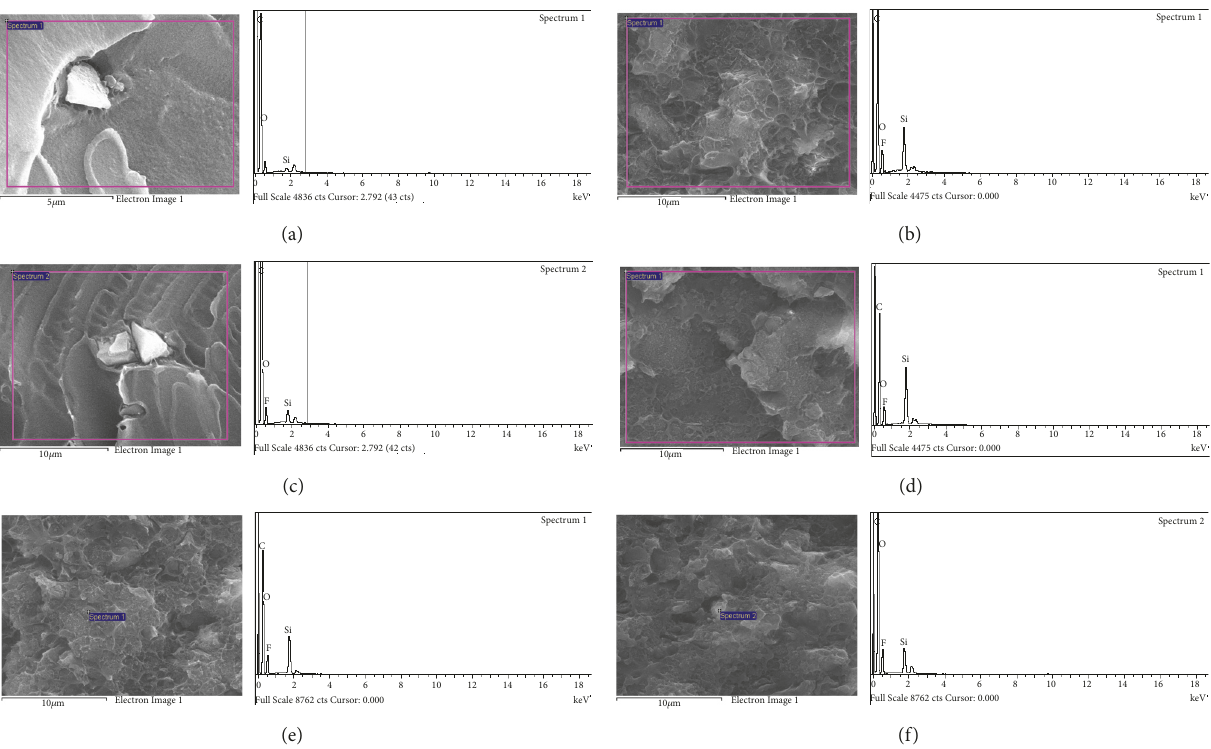
Figure 5: EDX spectra and electron images of prepared membranes with (a) PC-Sil, (b) 1.0:0.5, (c) 1.0:1.0, (d) 1.0:1.5, (e) 1.0:2.0, and (f) 1.0:2.5.